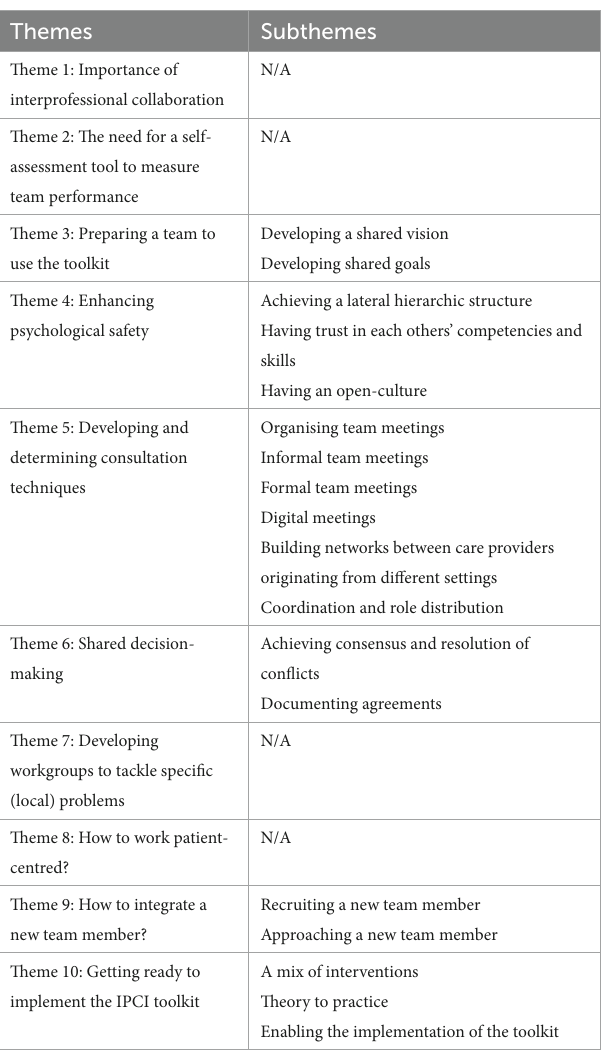
TABLE 7 An overview of the themes and subthemes extracted from the development